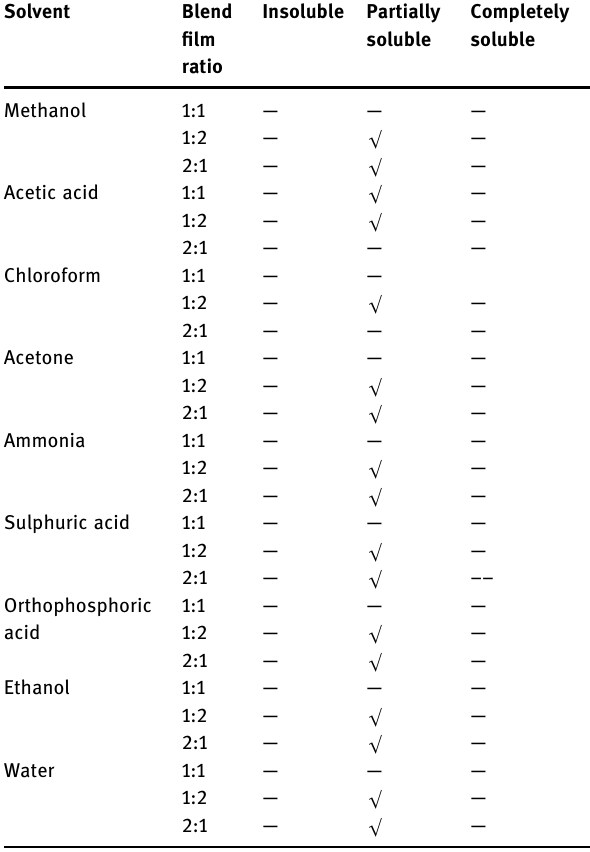
Table 1: Solubility test of the prepared fi lms with di ff erent ( PVP:CMC ) ratios in various solvent media Solvent Blend fi